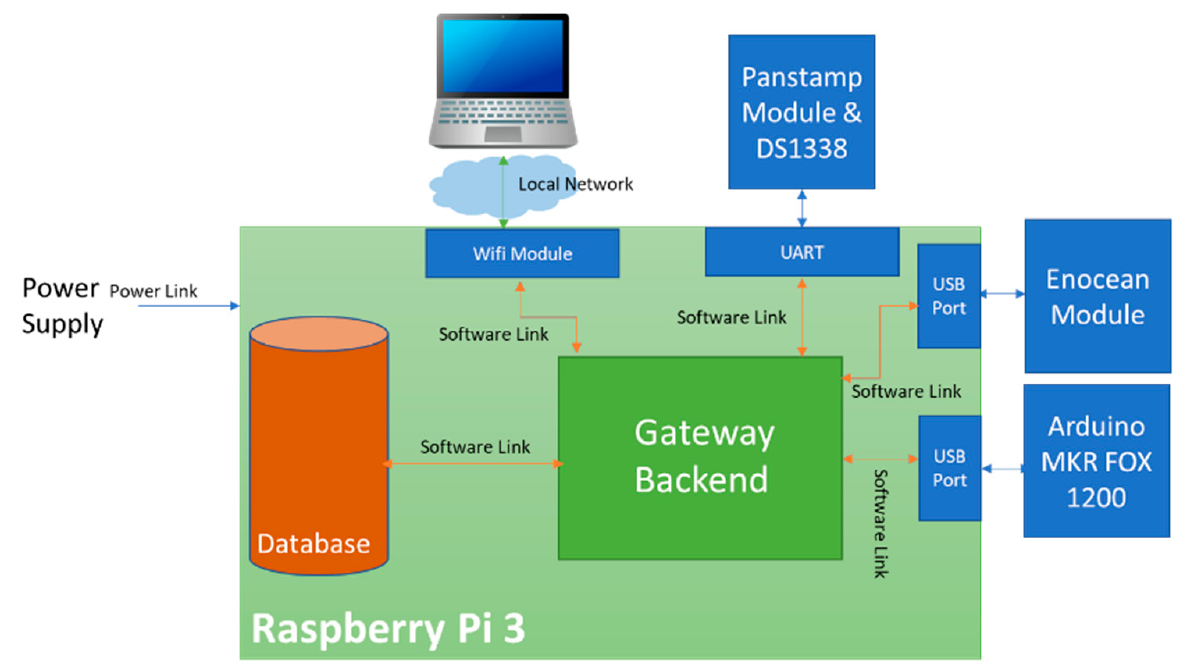
Figure 8. Block diagram of the local server with the software links.